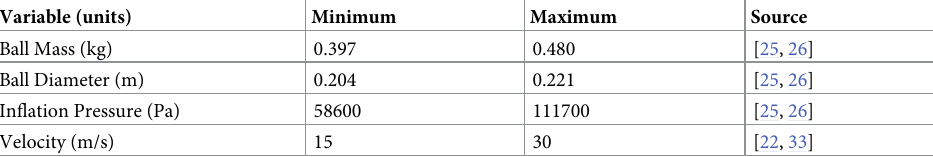
Table 1. Parameter ranges for sensitivity